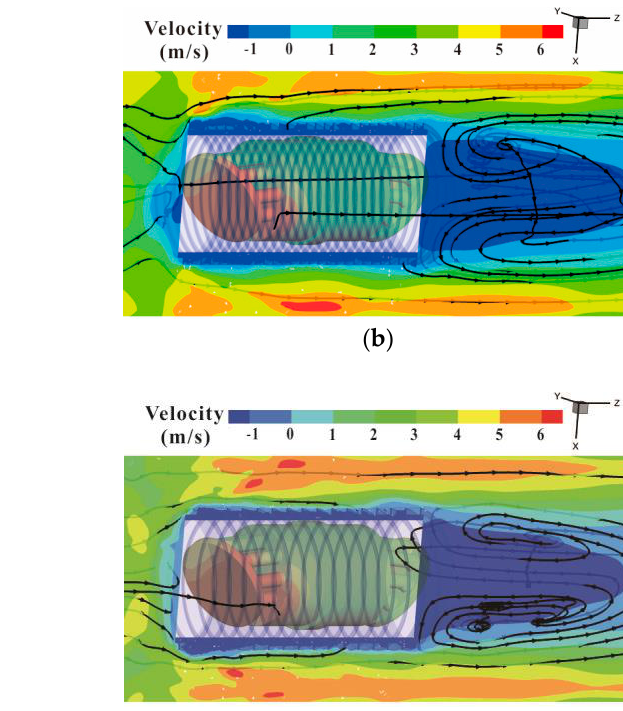
( b ) Figure 10. Temperature distribution with a fin height h = 10 mm and fin thickness t = 2 mm when ( a ) fin pitch p = 10 mm; ( b ) fin pitch p = 20 mm. The phenomenon of velocity separation appears in the outlet region of the CCAPT, where a wake region of large area is created, together with the conspicuous vortex. In this